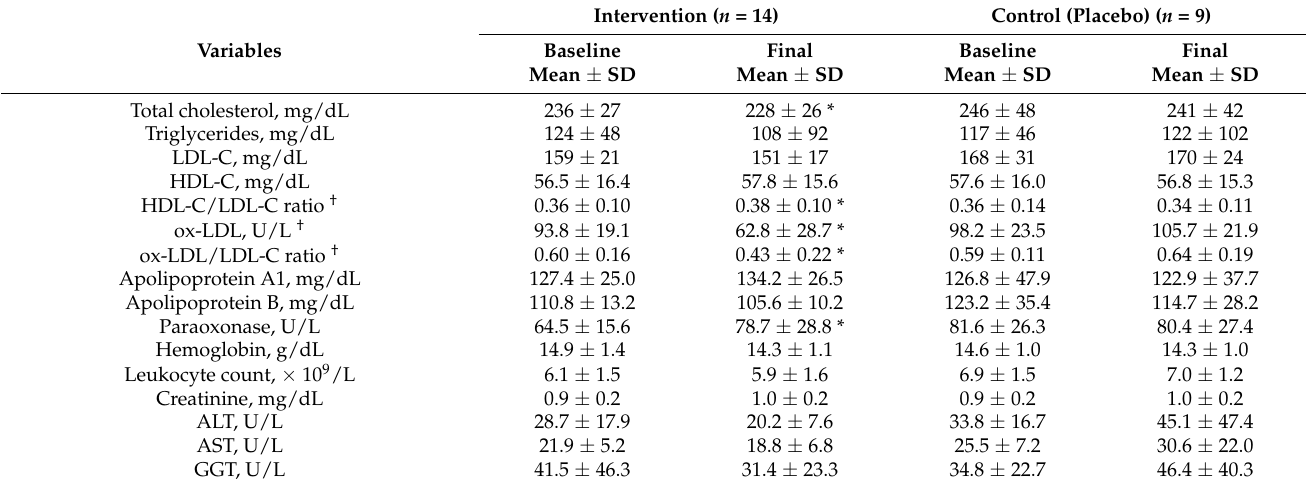
Table 3. Results of laboratory tests.